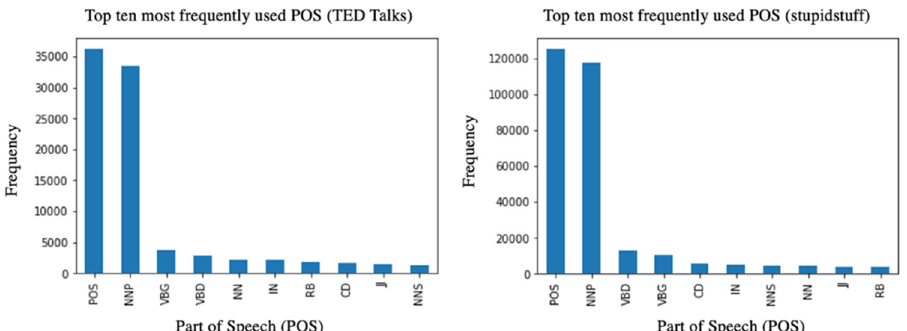
Figure 5. The 10 most frequently occurring POS for humorous sentences in TED Talks ( left ) and jokes from stupidstuff.org ( right ). Legend on POS tag definitions: POS (possessive ending), NNP (proper noun, singular), VBG (verb, gerund/present participle), VBD (verb, past tense), NN (noun, singular), IN (preposition/subordinating conjunction), RB (adverb), CD (cardinal digit), JJ (adjective), NNS (proper noun, plural).